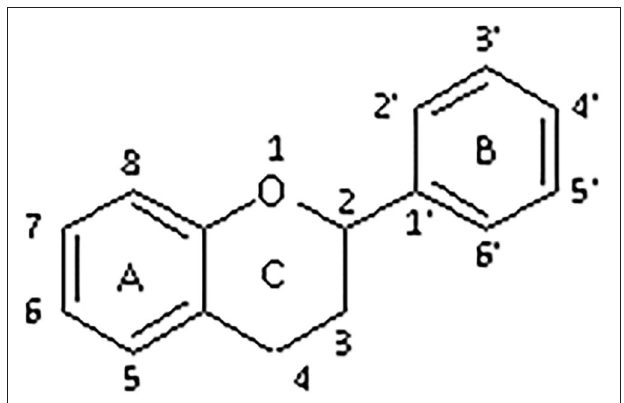
FIGURE 1 | Chemical structure of